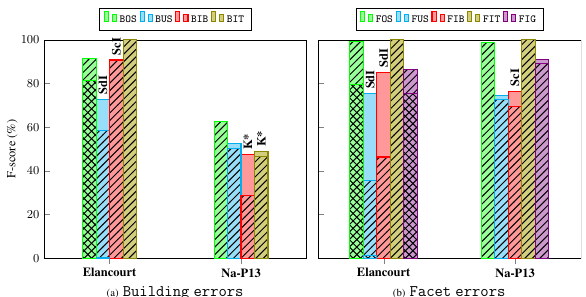
Figure 6. Best Vanilla F-scores out of all possible combinations with our proposed feature extractors (colors). Hash bars: north east lines for SVM and RF baseline and north west lines for the